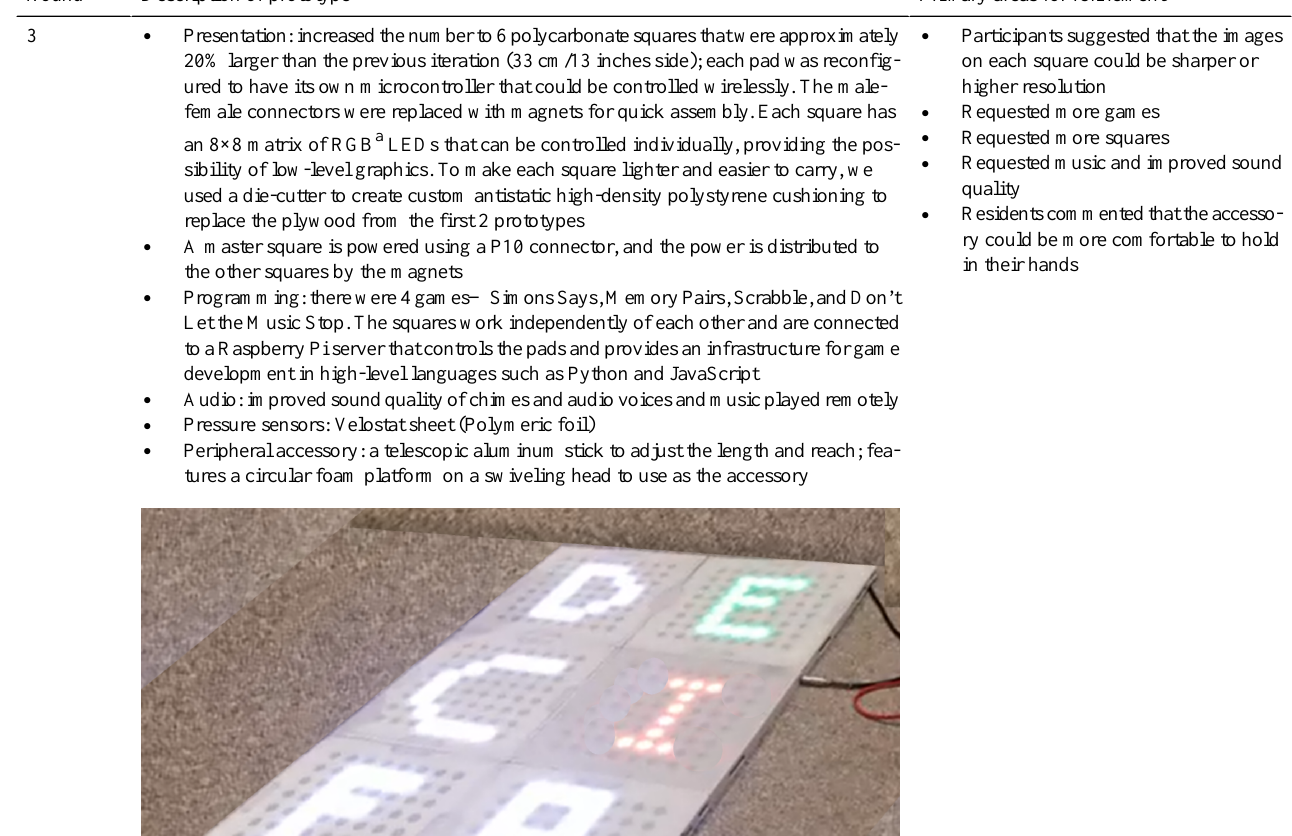
Primary areas for refinementDescription of prototypeRound • Participants suggested that the images on each square could be sharper